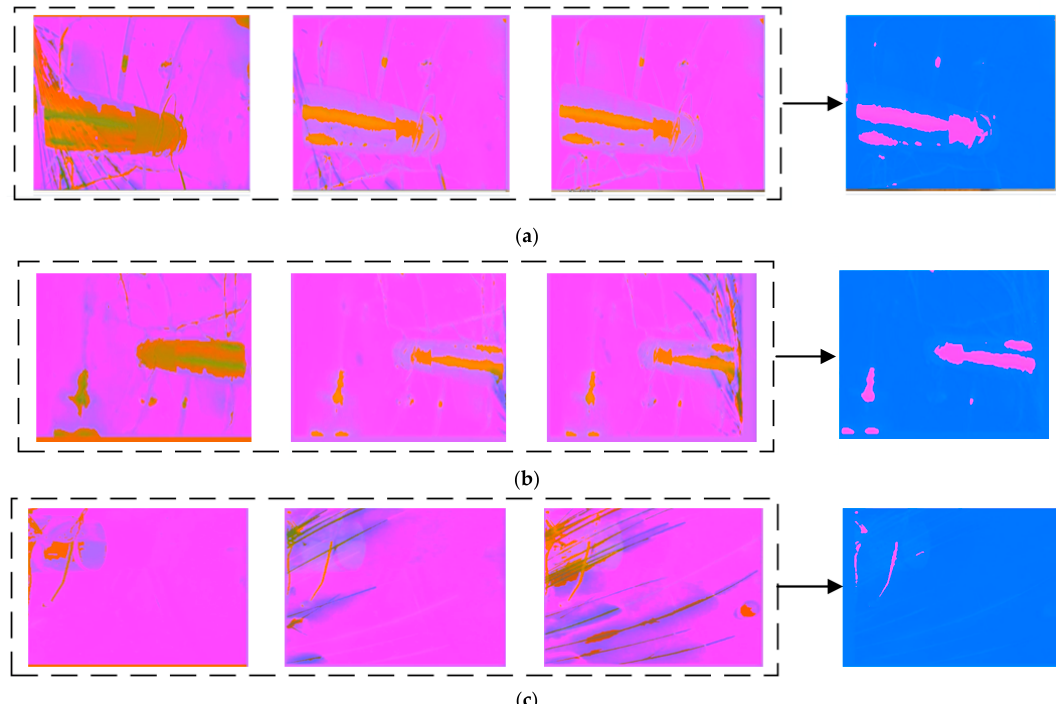
Figure 16. ( a – c ) present the encoding visualization results, generated from input image sequences with various anomalous sparks by the ConvLSTM-based motion-sensing encoder and ConvLSTM-based interference encoder. The visualization method scales each value of the three-channel two-dimensional tensors, output by the activation function, in the interval from 0 to 255, and displays it as an RGB image.